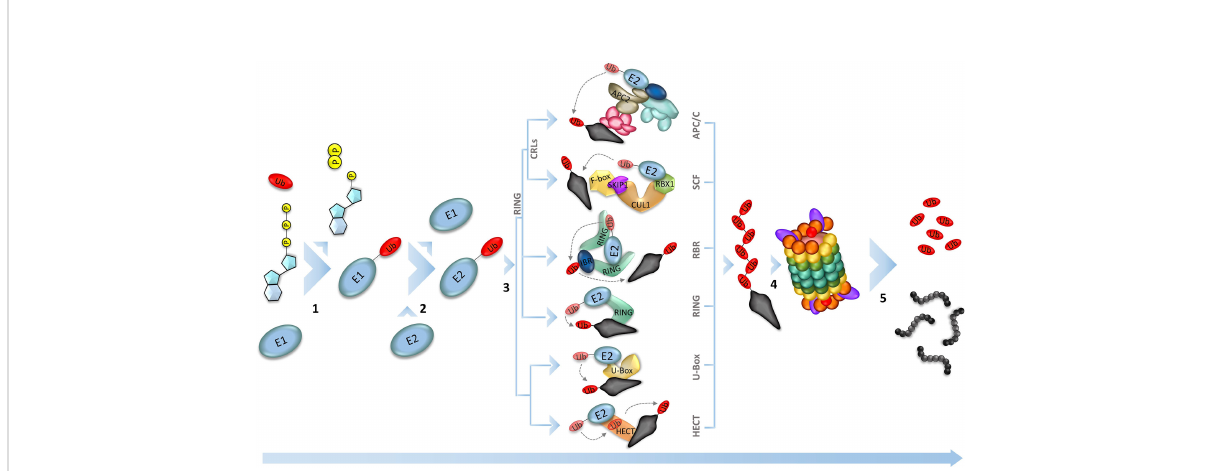
FIGURE 1 Ubiquitin-Proteasome System (UPS). The proteolysis in the UPS happens by sequential reactions catalyzed by three different enzymes. The process starts with the activation of the ubiquitin by the ubiquitin-activating enzyme (E1), using an ATP molecule (1). Next, the activated ubiquitin is transferred to the ubiquitin-conjugating enzyme (E2), which is responsible to interact with the ubiquitin ligase (E3) and conjugate the ubiquitin to the substrate that is recognized by the E3 (2). Plant genomes encode hundreds of E3 ligases (the main E3 ligases found in plants are represented in 3), that will target the different substrates, making them recognizable by the proteasome 26S, leading to the substrate degradation